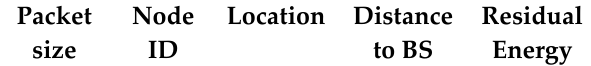
Figure 7. Sleep-awake rotation.